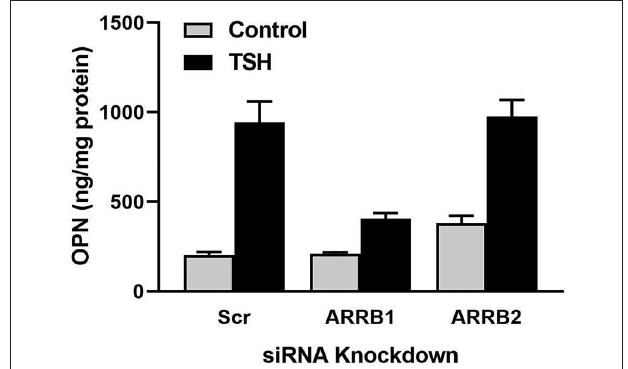
FIGURE 1 | β -arrestin 1, but not β -arrestin 2, mediates OPN secretion. U2OS-TSHR cells were treated with non-targeting (scramble siRNA, Scr), β -arrestin 1 (ARRB1), or β -arrestin 2 (ARRB2) siRNAs for 24h. After 72h, the cells were incubated with 2 µ M TSH in EMEM supplemented with 0.1% BSA for 5 days prior to the ELISA measurement of OPN secreted into the cell culture media ( 21).